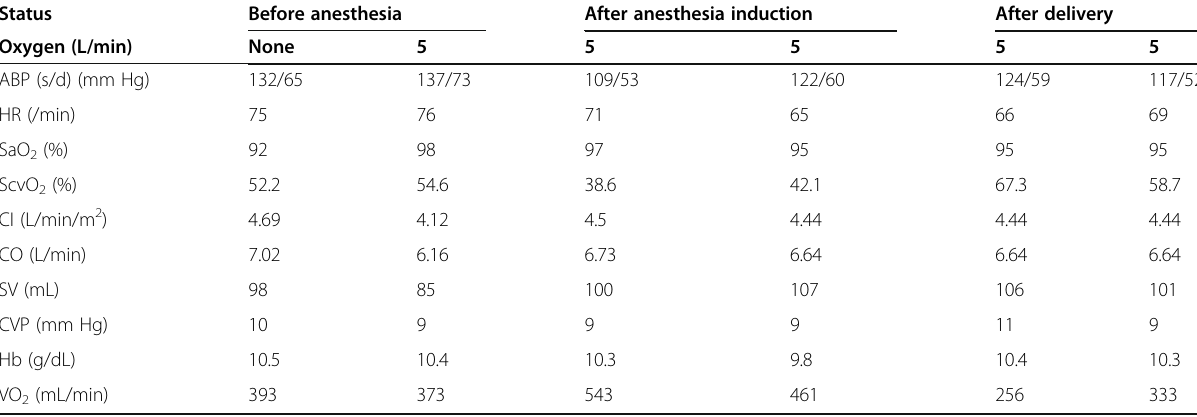
Table 1 Perioperative hemodynamic parameters Status Before anesthesia After anesthesia induction After